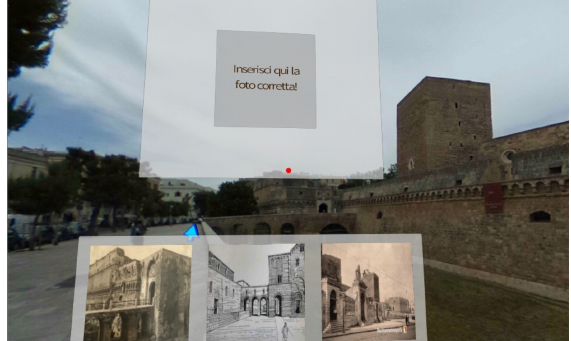
Figure 5. Initial screen of the postcard game.